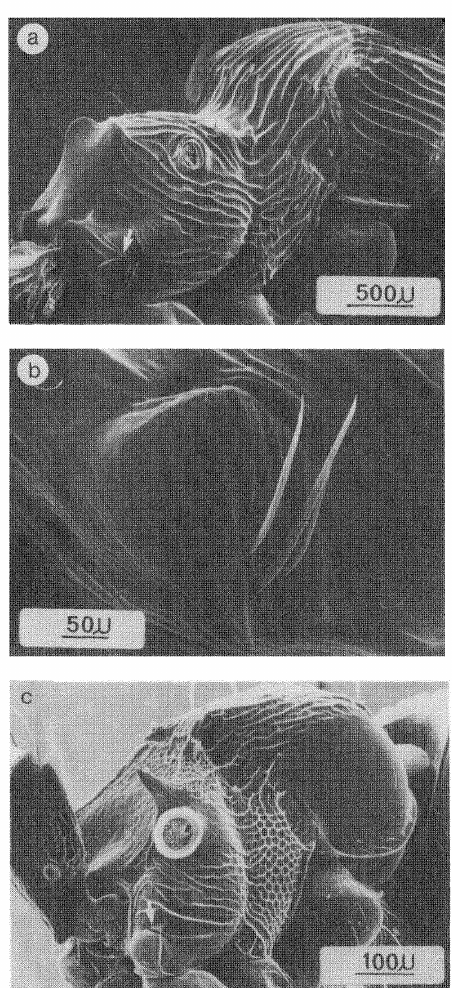
Fig. 7. (Above and facing page) SEM micrographs of the exterior structures of the metapleural glands of several ant species, a. Alitrunk of Podom.vrma pulchra worker, b. Close-up of bulla, slit-shaped opening and sensory hairs (?) of the metapleural gland of P. pulchra worker, c. Alitrunk of Crematogaster sp 10 (ANIC) worker, d. Alitrunk of Catalacus intrudens worker, e. metapleural gland opening with sensory hairs (?) of C. intrudens worker, f. Alitrunk of Crematogaster sp 10 (ANIC) male. Arrows point to the opening of the metapleural